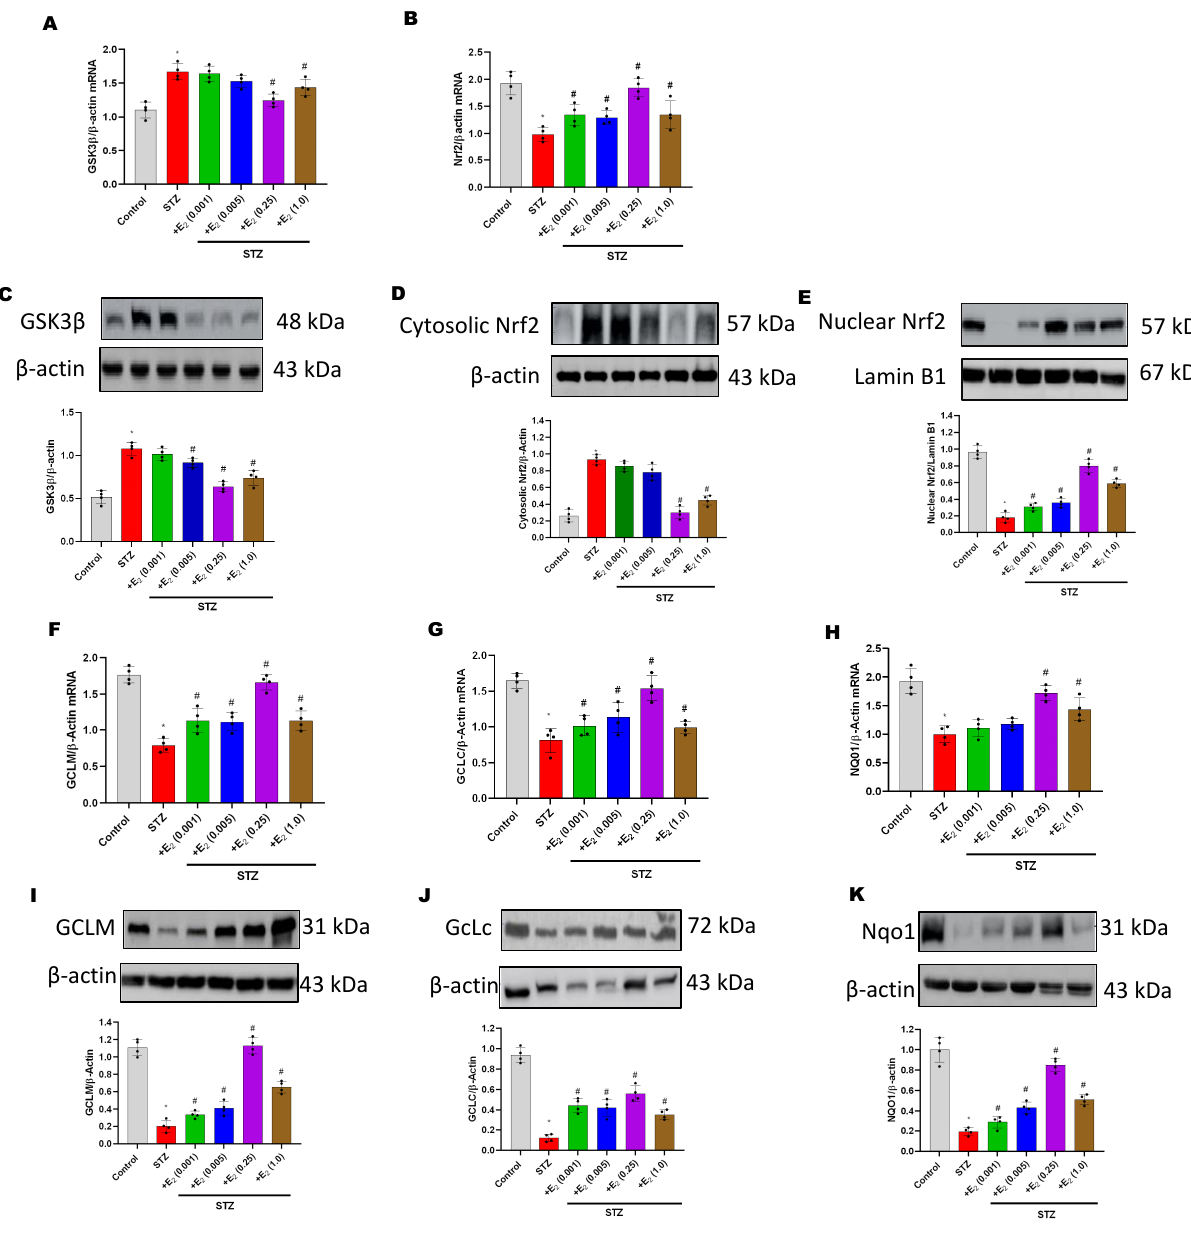
Figure 3. Effect of 17 β -estradiol (E 2 ) on levels of GSK-3 β , cytosolic Nrf2, nuclear Nrf2, and Phase II enzymes in STZ-induced diabetic mice. Total RNA was isolated from the gastric antral tissues. qRT-PCR was used to measure the level each indicated mRNA. Data presented were normalized to the mRNA level of the β -actin gene ( A , B , F – H ). Representative immunoblot and densitometry analysis for protein levels of GSK-3 β ( C ), cytosolic Nrf2 ( D ), nuclear Nrf2 ( E ), and Phase II enzymes (GCLC, GCLM, NQO1) ( I – K ) in gastric neuromuscular tissue. Stripped blots were re-probed for β -actin. Densitometry data for target proteins were normalized to the protein levels of β -actin. Bar graphs depict the ratios of levels of target genes or proteins to those of β -actin. Data were analyzed with one-way ANOVA using GraphPad Prism. Data are means ± SEM ( n = 4). * denotes p < 0.05; significantly different from healthy mice (Con). # denotes p < 0.05; significantly different from STZ- induced diabetic mice (STZ). Legends: glycogen synthase kinase 3 beta (GSK-3 β ), nuclear factor erythroid 2-related factor 2 (Nrf2), streptozotocin (STZ), glutamate-cysteine ligase (GCL (catalytic subunit ( C ) and modifier subunit (M)), NAD( p )H quinone dehydrogenase 1 (NQO1) ribonucleic acid (RNA), real-time quantitative reverse transcription PCR (qRT-PCR), messenger ribonucleic acid (mRNA), analysis of variance (ANOVA), standard error of the mean